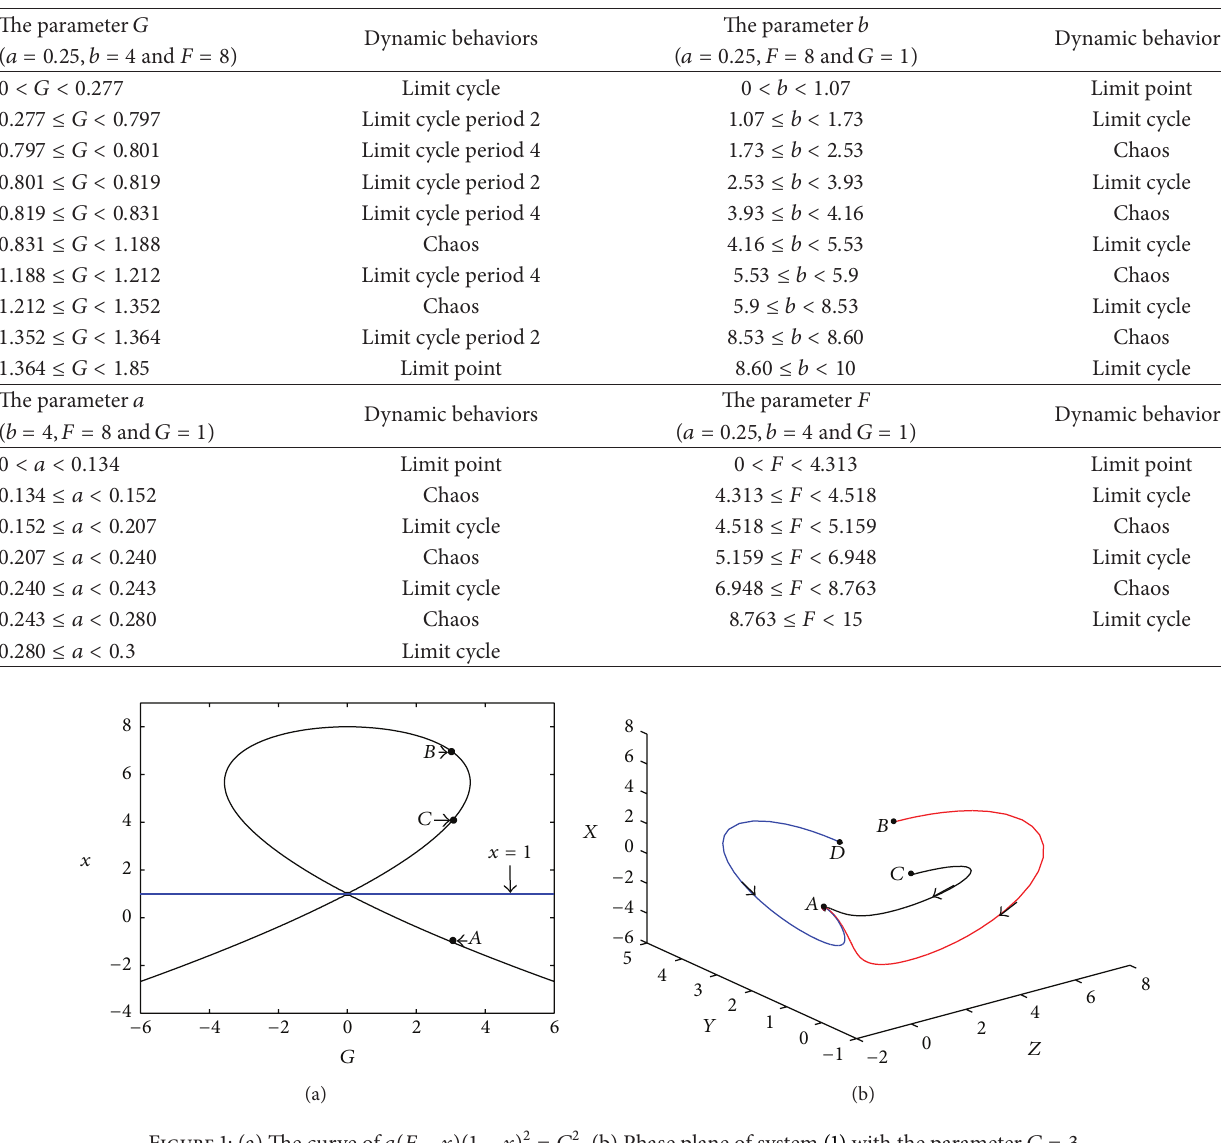
Table 1: The dynamic behaviors of model (1) about the parameters 𝐺 , 𝑏 , 𝑎 , and 𝐹 .